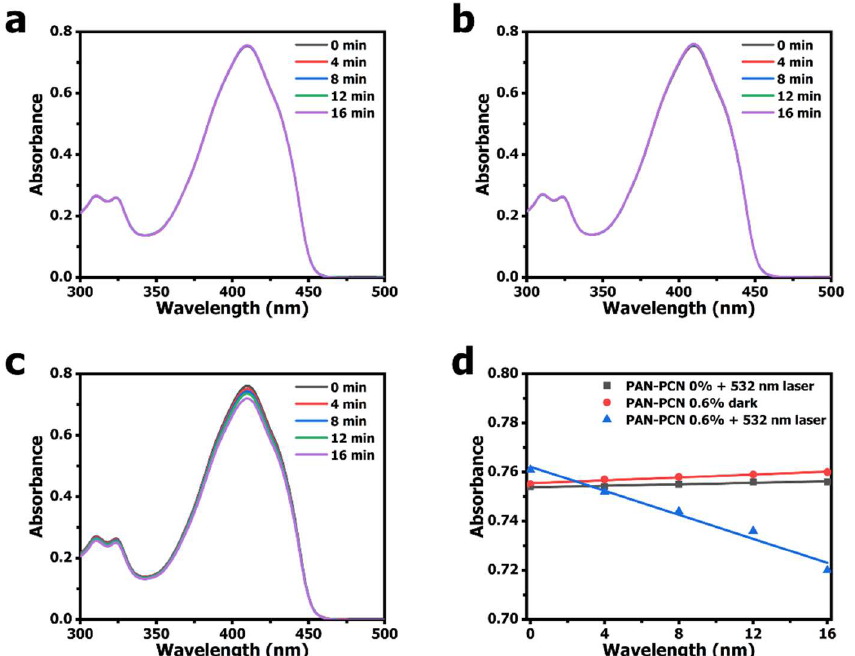
Figure 7. Absorbance spectra of DPBF (1,3-diphenylisobenzofuran) in the presence of PAN-PCN 0.6% under illumination. The spectrum curves were collected every 4 min under a handheld laser. ( a ) DPBF absorbance spectra in the presence of PAN-PCN 0% under laser illumination. ( b ) DPBF